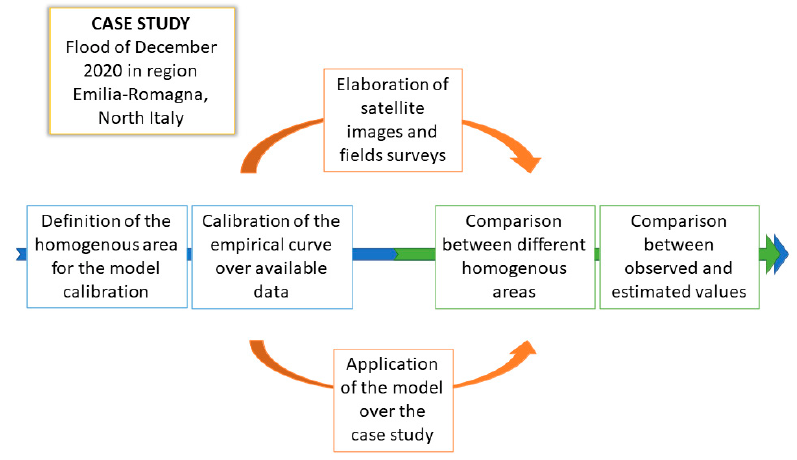
Figure 1. Workflow.